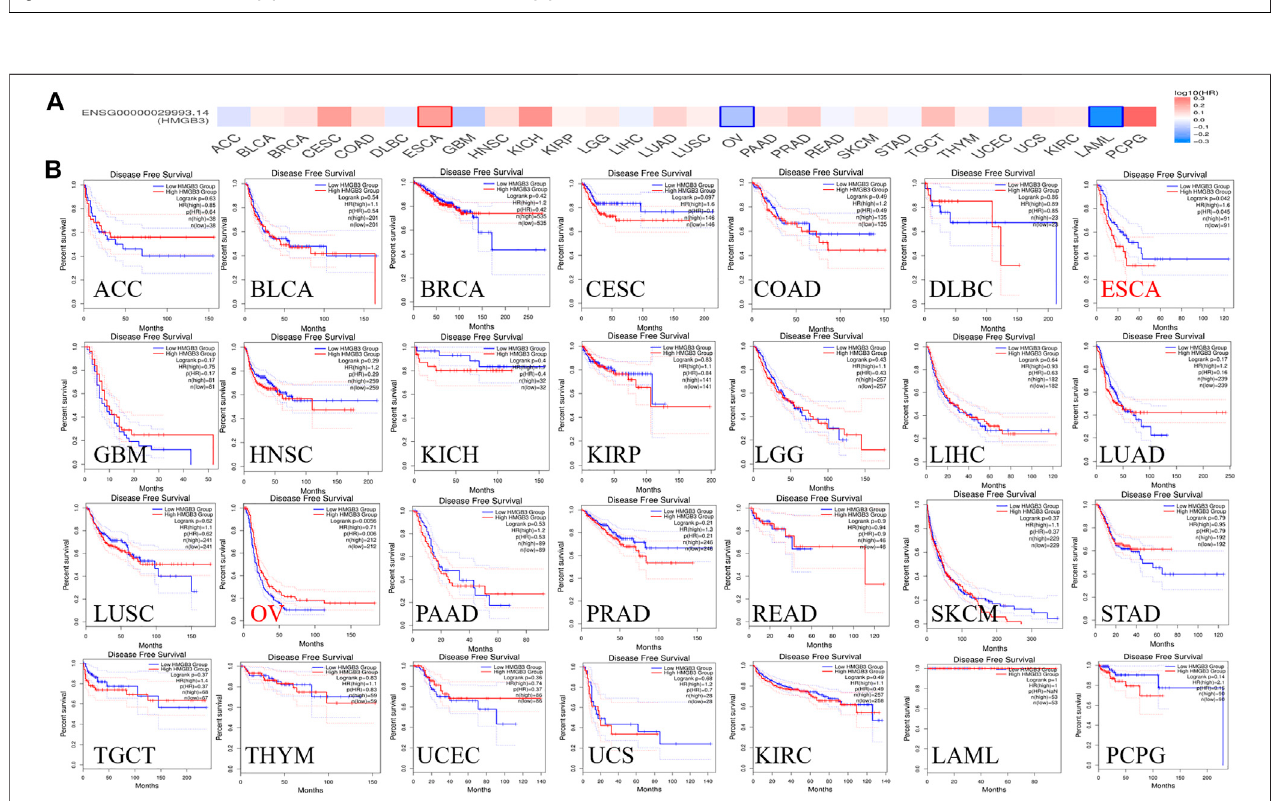
FIGURE 4 | The correlation between HMGB3 gene and DFS data in tumors. (A) Survival map in HMGB4 abnormally expressed tumors; (B) DFS data in HMGB3 tumors, logrank p > 0.05.